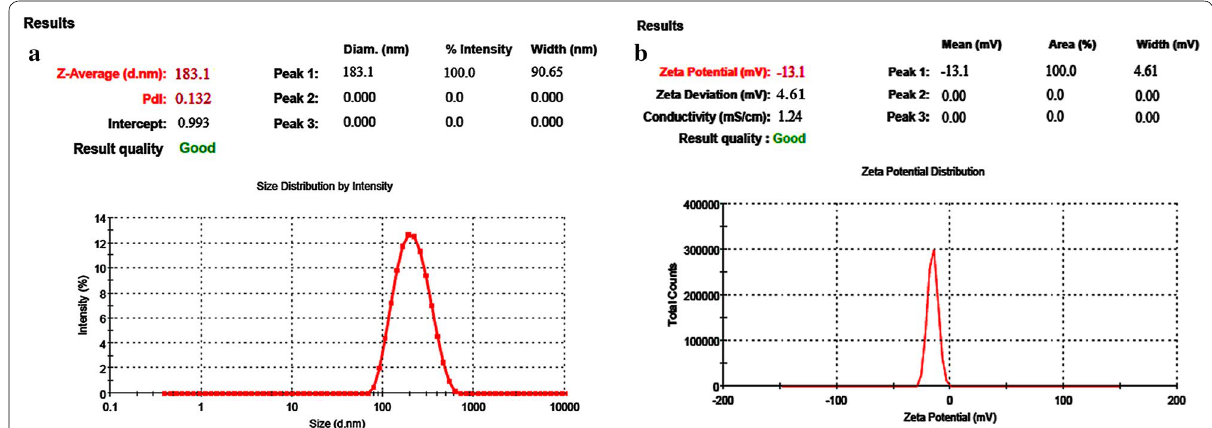
Fig. 1 Dynamic light scattering techniques for determining the particle size distribution of DOX-loaded-PEG-PLGA-NPs Globule Size, ( a ) and zeta potential, ( b